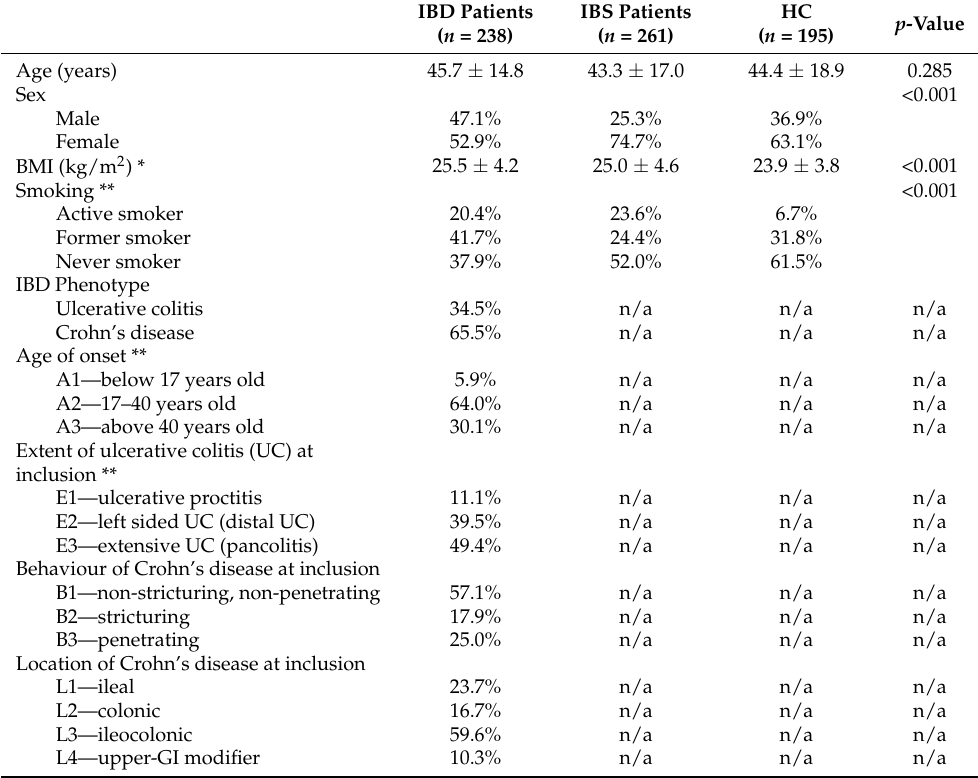
Table 1. Baseline